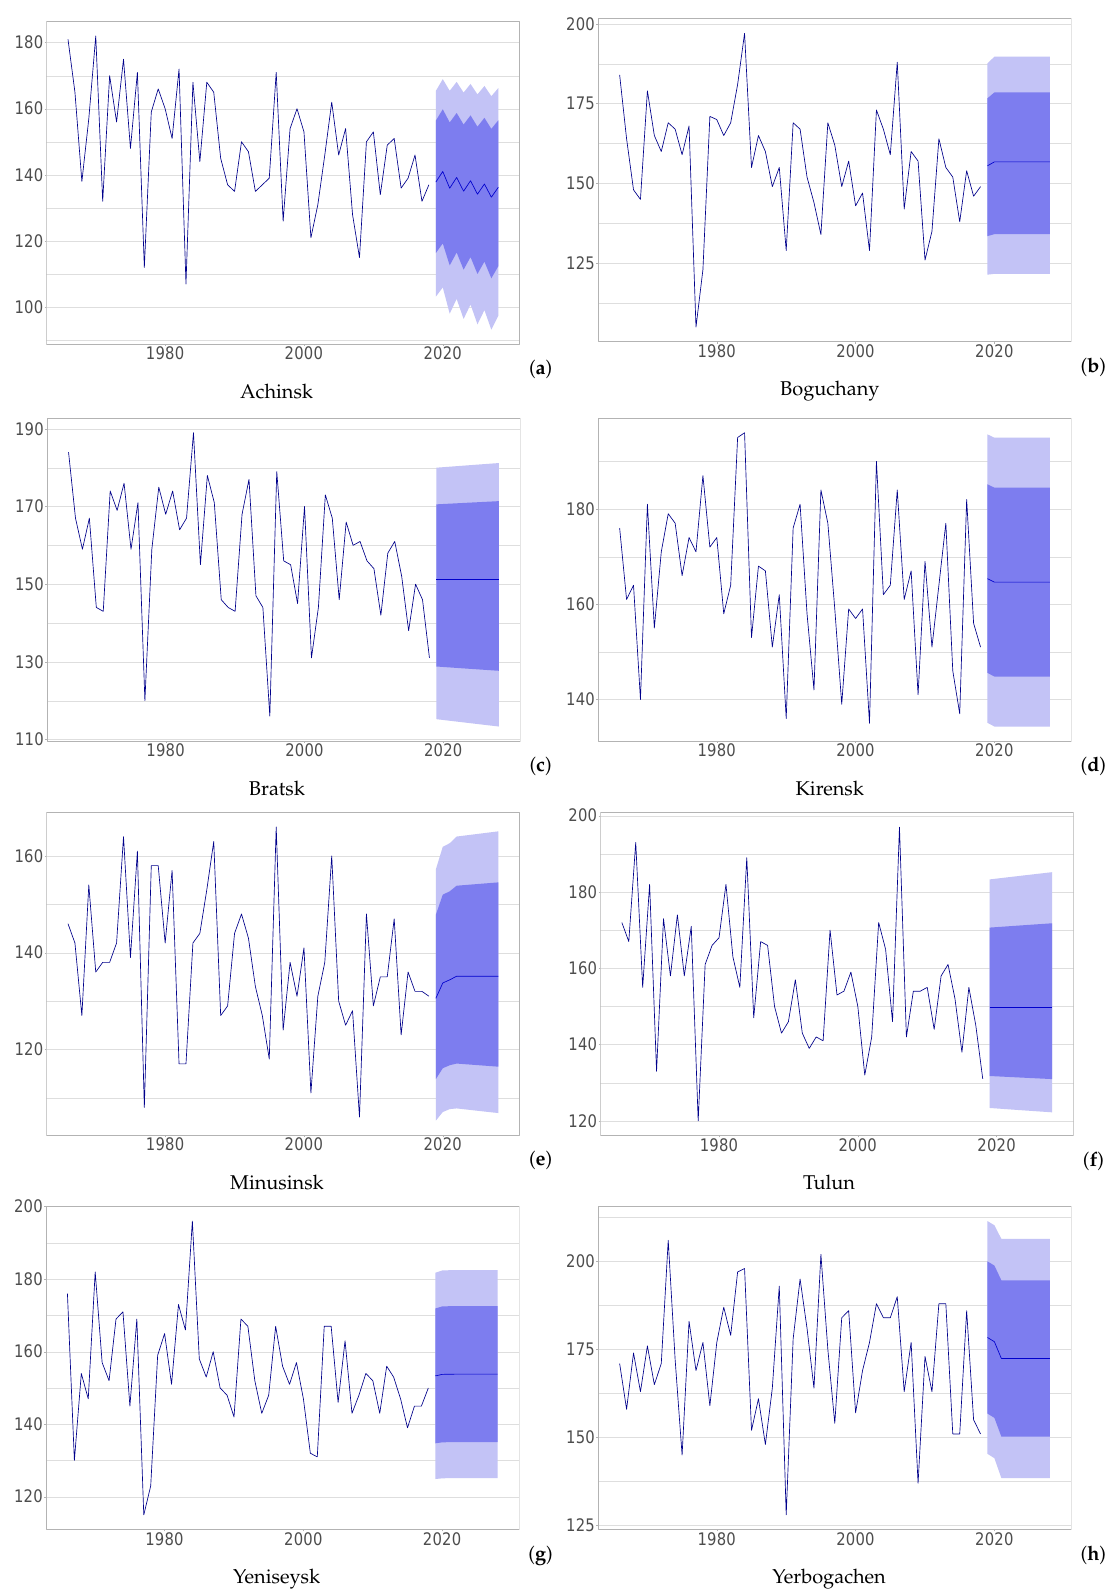
Figure 7. Point forecasts and forecast intervals at 80% and 95% levels of the expected duration of logging season by stations predicted with autoregressive-integrated-moving average modeling (ARIMA)